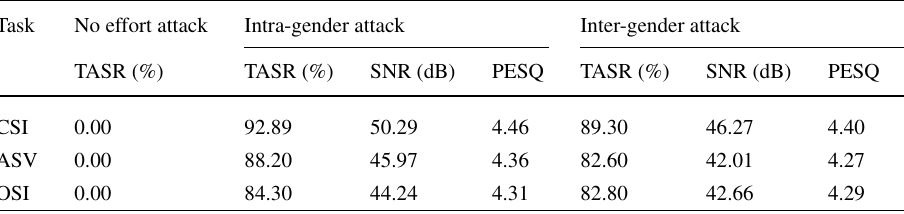
Table 5 Performance of the proposed method for matched attacks on i-vector with d (cid:2) L /3, λ (cid:2) 0.005 and ζ (cid:2) 0.003